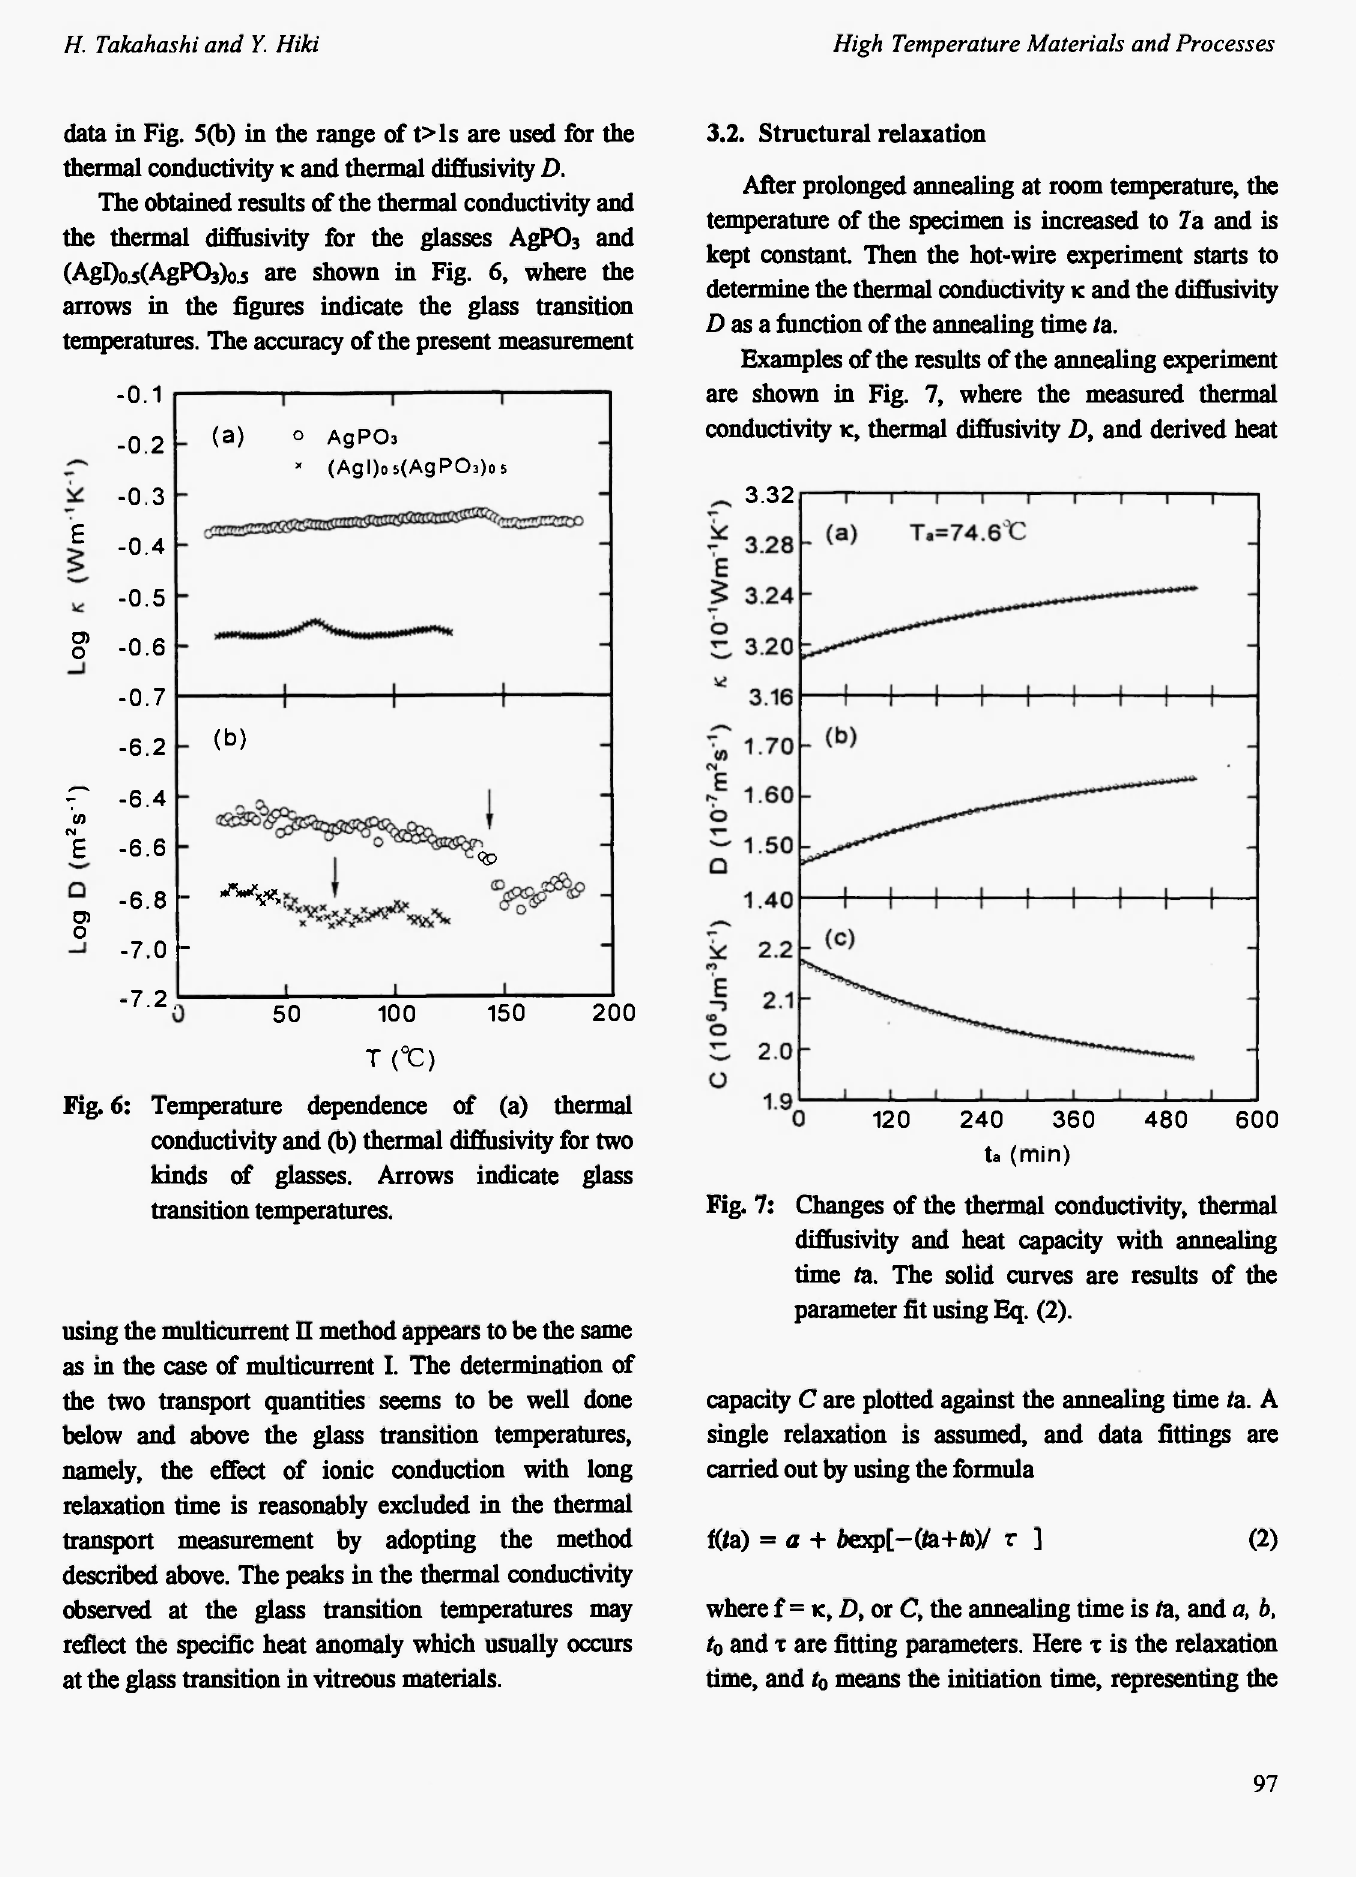
Fig. 6: Temperature dependence of (a) thermal conductivity and (b) thermal diflusivity for two kinds of glasses. Arrows indicate glass transition temperatures. Fig. 7: Changes of the thermal conductivity, thermal